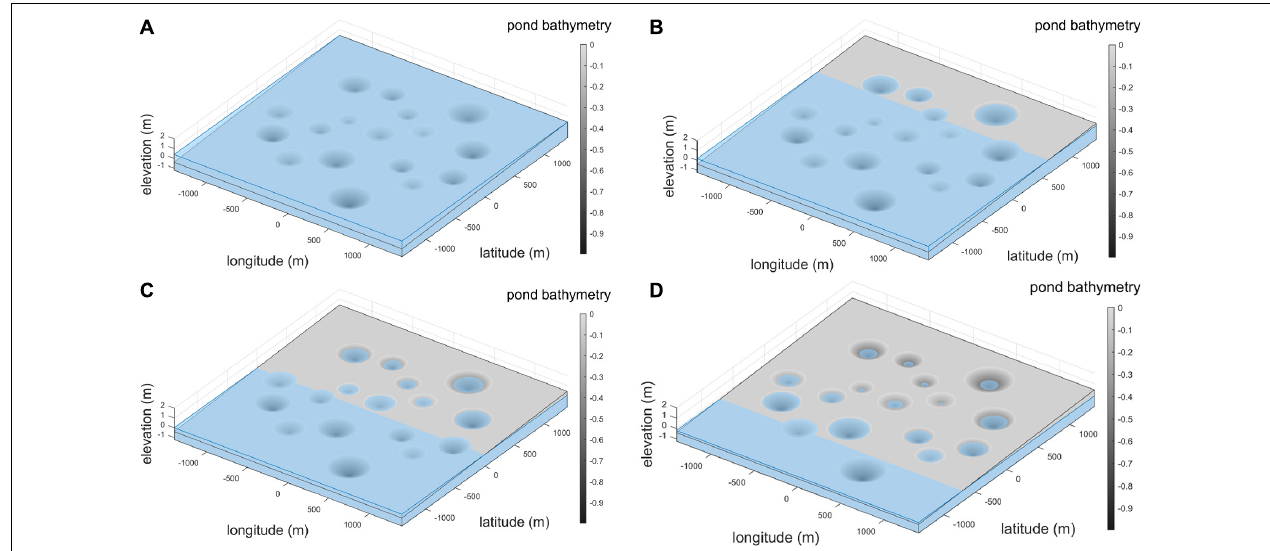
FIGURE 4 | Change in local pond dynamics with regional scale drying pattern. (A) Wet season, (B) early dry season, (C) middle dry season, (D) late dry season.